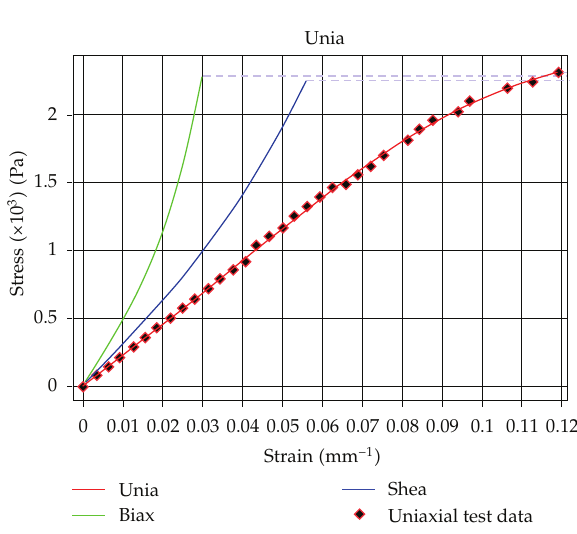
Figure 1: Stress-strain curves for gray matter.